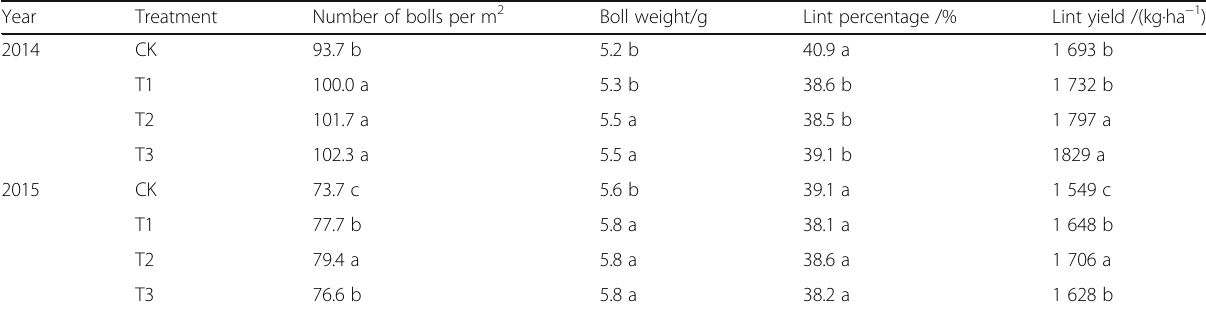
Table 4 Cotton yield and yield components in different treatments in 2014 and 2015 Year